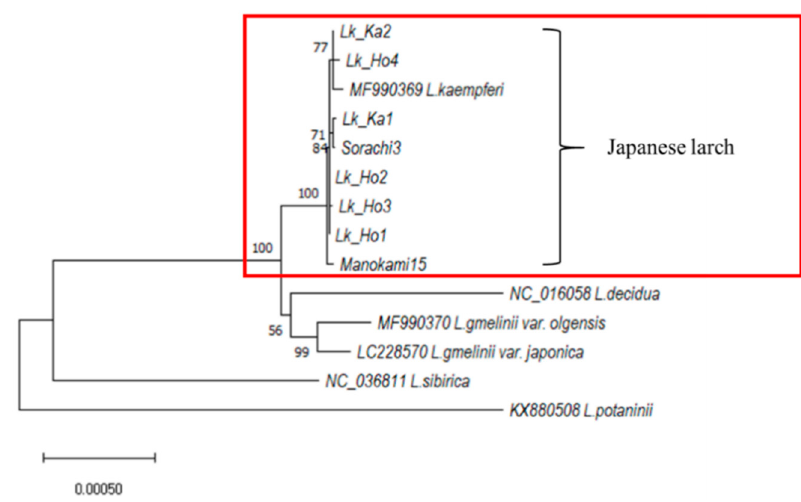
Figure 1. The maximum likelihood (ML) phylogenetic tree based on 14 chloroplast genomes of Larix species. The red square represents Japanese larch.